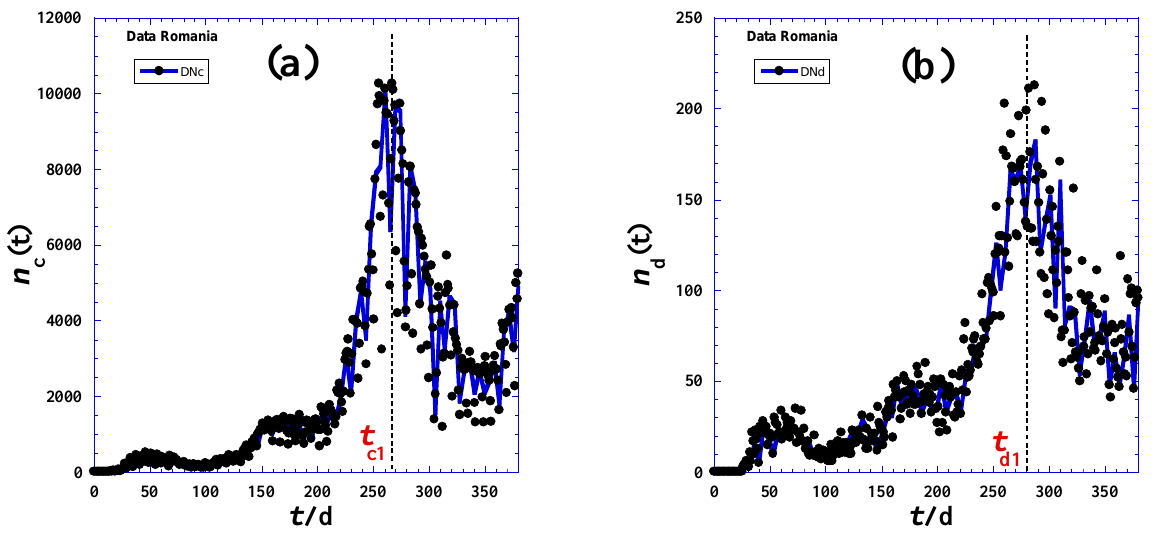
Figure 2. New daily reported cases ( a ) and new daily reported deaths ( b ) for the first 380 days of the pandemic in Romania.